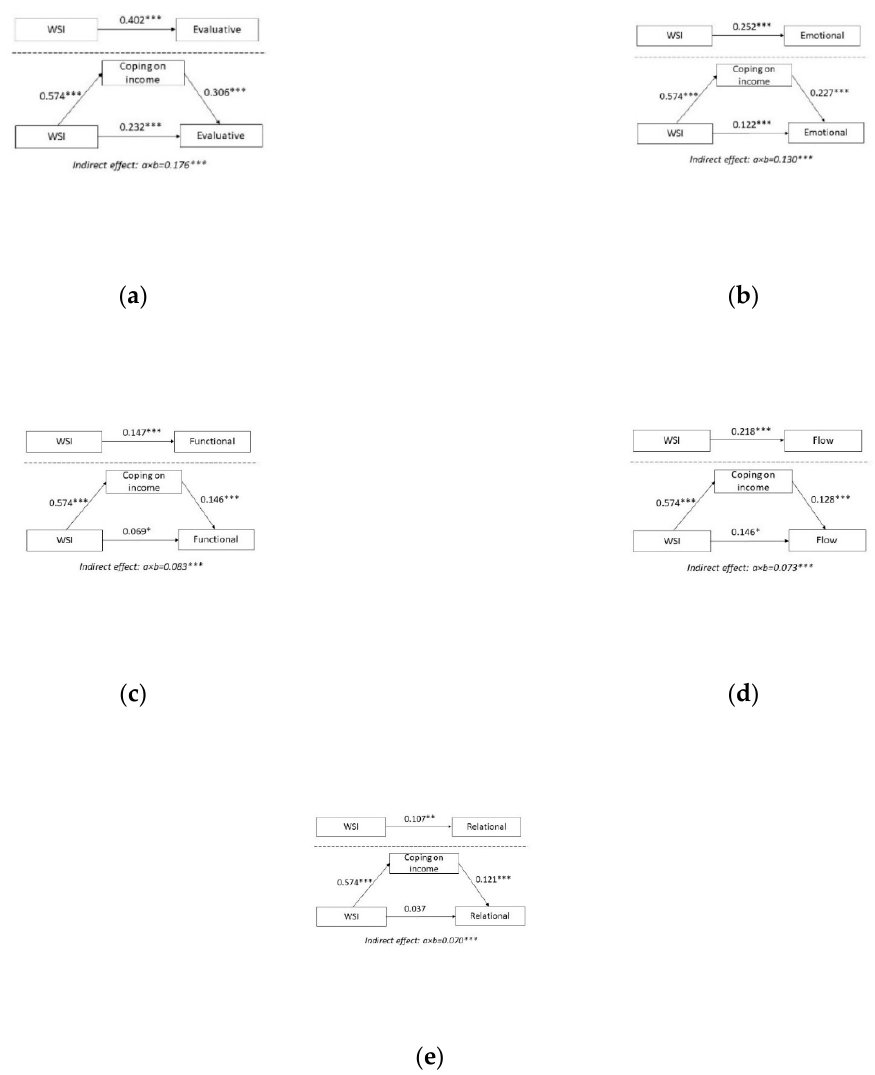
Figure A2. Coping with income intervening variable: ( a ) Evaluative dimension. ( b ) Emotional dimension. ( c ) Functional dimension. ( d ) Flow dimension. ( e ) Relational dimension. Significance level denoted by stars as follows: *** p <